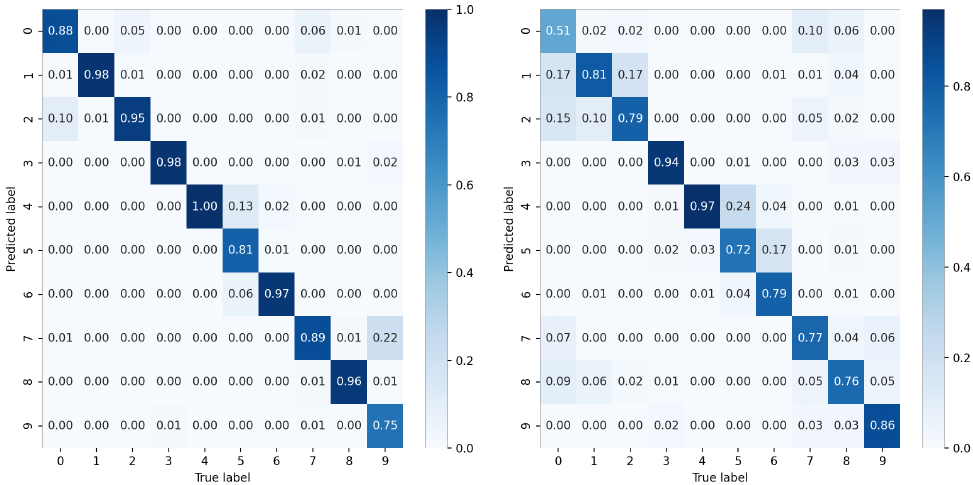
Figure 12. Confusion matrix of the CNN for 10 classes. The left is the confusion matrix of original data. The right is the confusion matrix of the data generated by our proposed